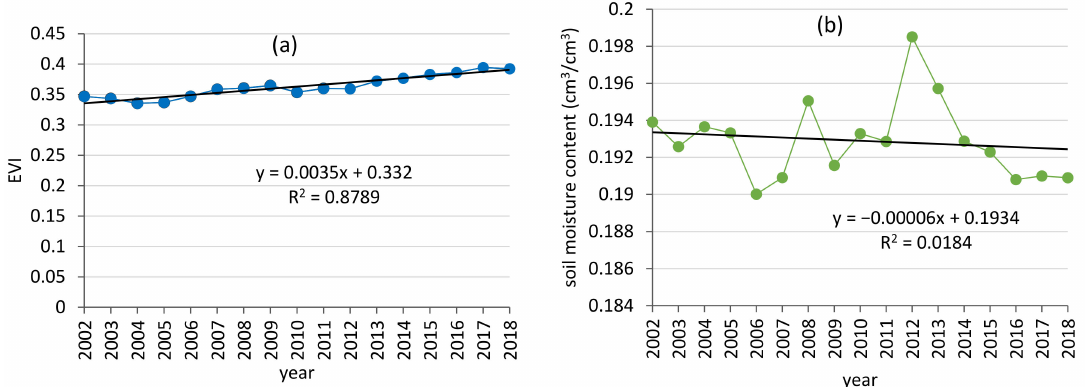
Figure 3. Temporal variation of ( a ) the annual average EVI and ( b ) the soil moisture content in the humid karst areas during